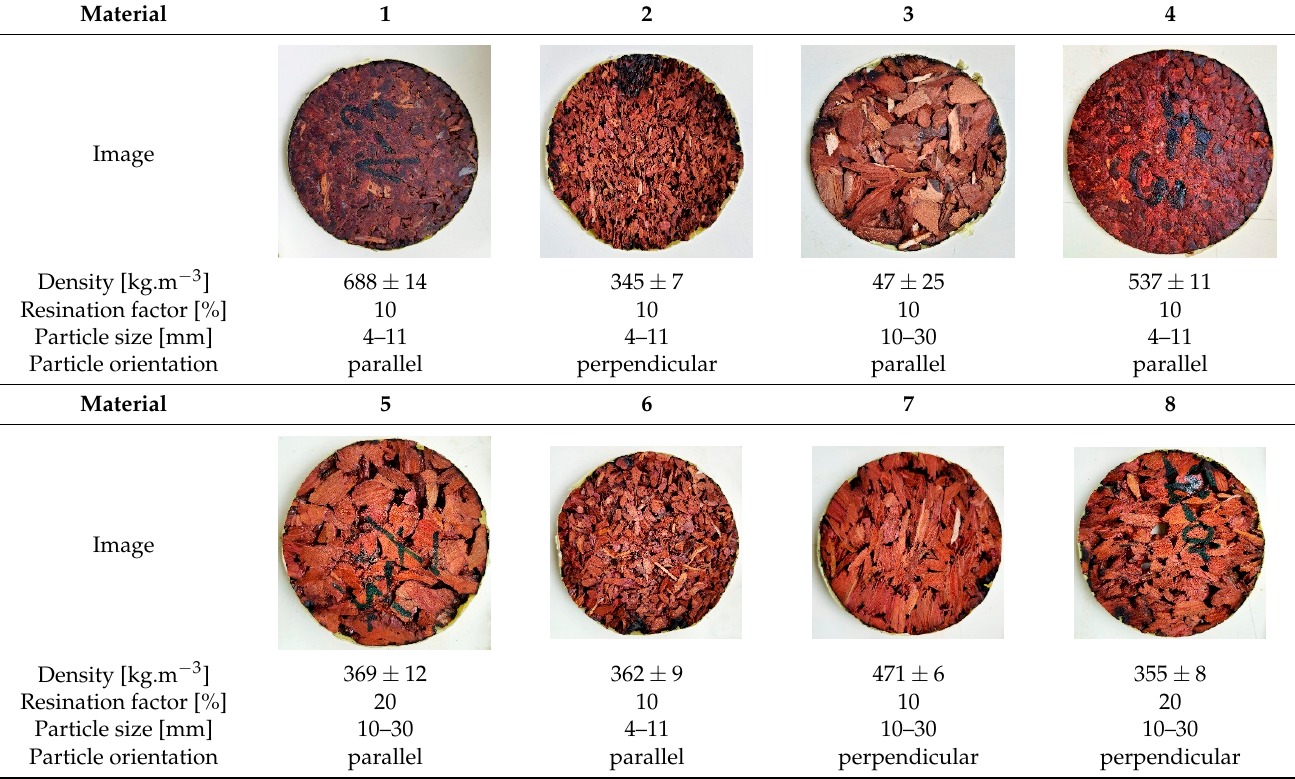
Table 1. Design parameters of measured materials.